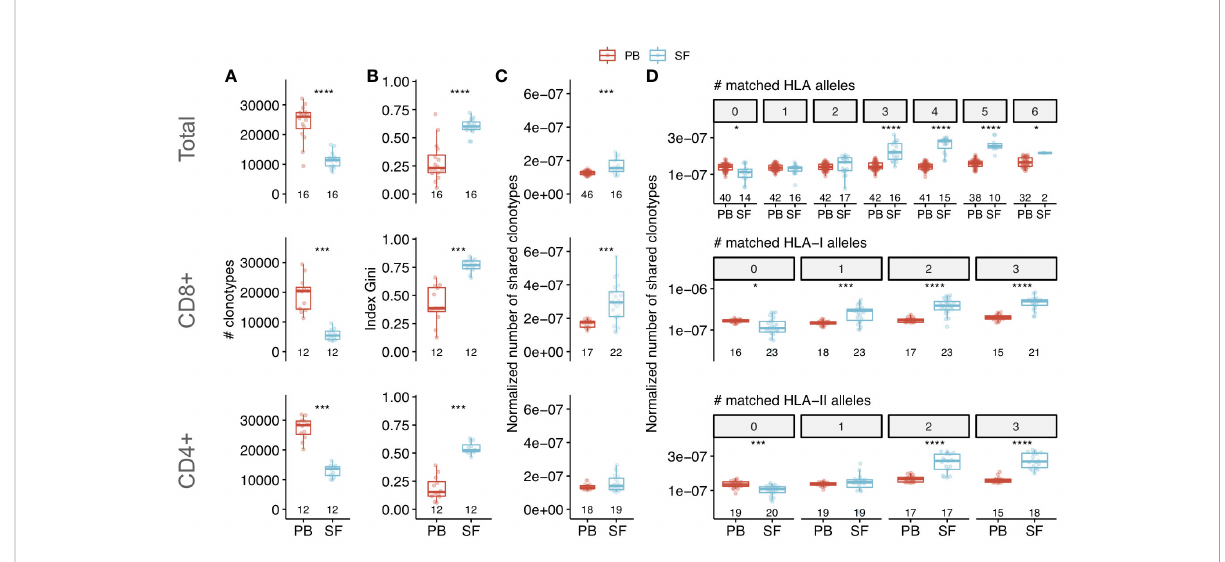
FIGURE 1 Characteristics of clonal T cell repertoire of synovial fl uid from patients with SpA. Comparison of clonal diversity (species richness) (A) and oligoclonality (B) between PB and SF repertoires of SpA patients (by Wilcoxon signed-rank test). Oligoclonality is measured by Gini index that equals 0 in even distribution of frequencies and 1 in monoclonal sample. (C, D) Normalized number of shared clonotypes (i.e., having identical CDR3 amino acid sequence and TRBV-segment) per donor in total (C) or depending on the number of matched HLA alleles (D) between donors (Wilcoxon rank sum test). Each dot represents an individual sample. For patients with relapses only repertoires of time point 1 were included in the analysis. Values below the box plots denote the number of donors. The middle line of a box corresponds to the median, the lower and upper hinges correspond to the 25th and 75th percentiles, respectively. The upper and lower whiskers extends from the hinges to the largest and smallest values no further than 1.5 * IQR from the corresponding hinge. Top, middle and bottom panels correspond to the repertoires of total, CD8+ and CD4+ T cells respectively. To assess diversity and clonal sharing repertoires were in silico equalized to the same sequencing depth. PB - peripheral blood, SF - synovial fl uid, HLA - human leukocyte antigen. *p < 0.05, ***p < 0.001, ****p <